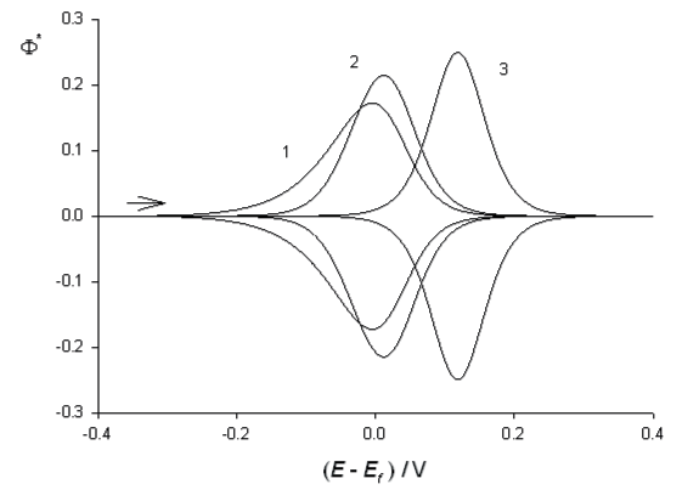
Fig. 1 Cyclic voltammetry of reversible electrode reaction (1) under thin film conditions (eq.